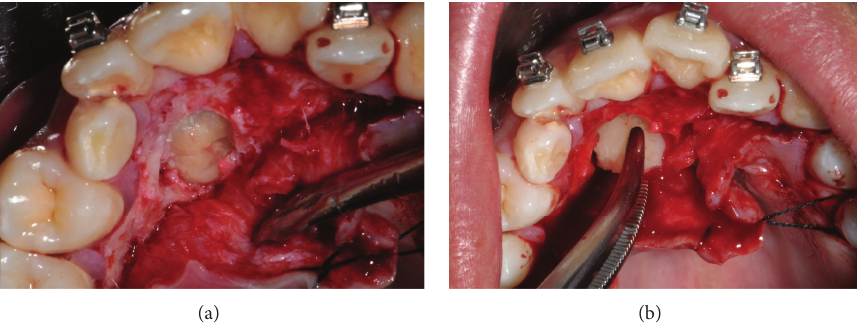
Figure 5: Permanent canine extraction.